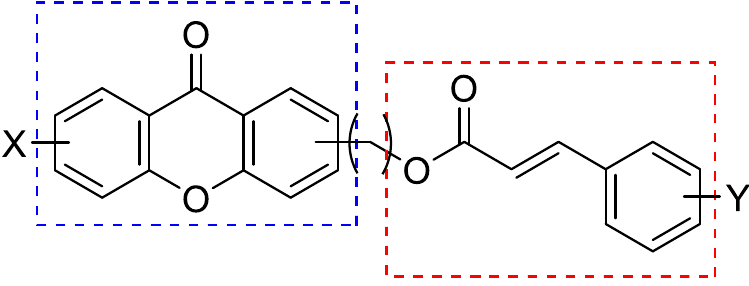
Figure 3. The design concept of the novel UV filters: combination of xanthone and ( E )-cinnamoyl chromophores.